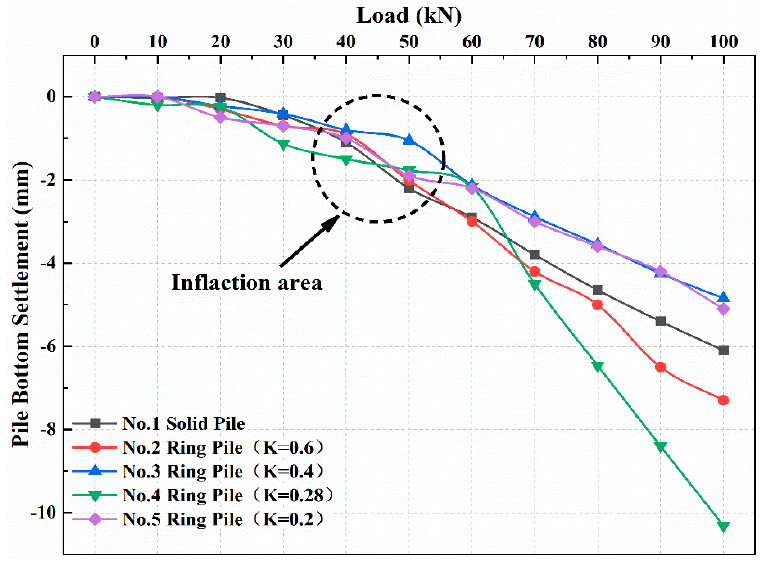
Figure 8. The settlement of pile bottom.